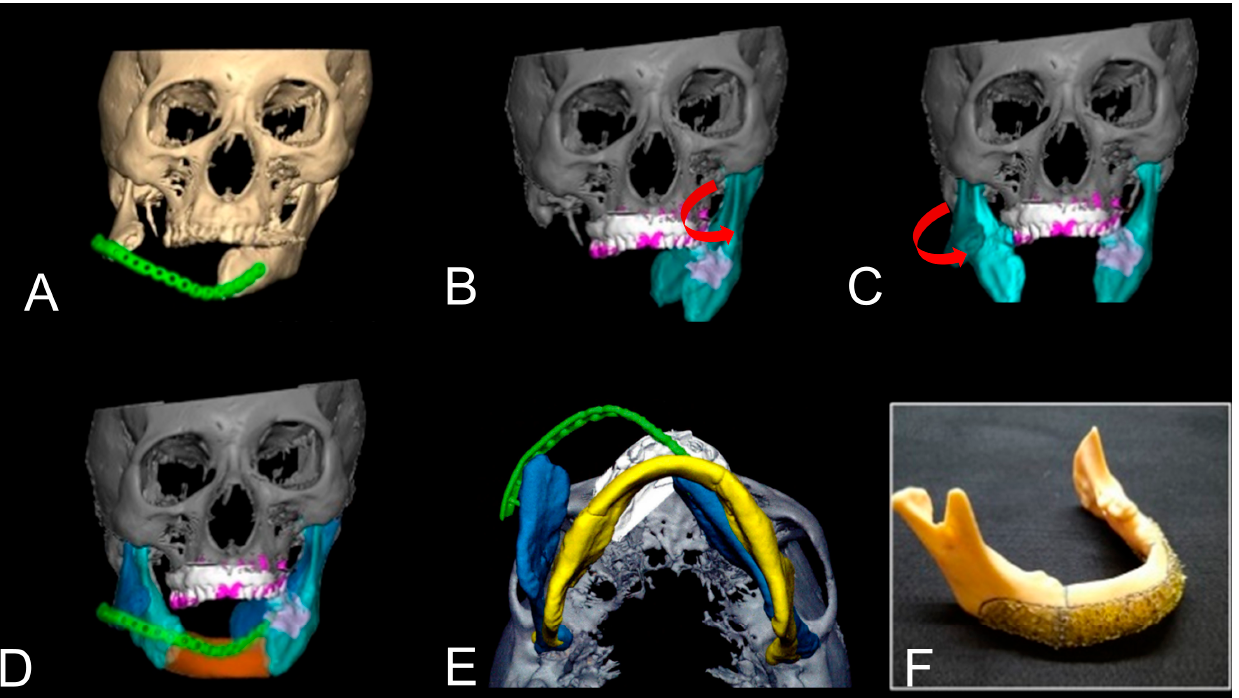
Figure 7. Complicated mandibular deviation without preoperative CT data. This was a case of bilateral segmental mandibular defect due to a tumour resection with radical neck dissection (Case 14). The defects were reconstructed with a surgical plate simultaneously. However, the surgical plate was located in the incorrect place and bilateral condylar displacements were seen. The facial appearance was poor and the alveolar bone for the dental rehabilitation was also improper ( A ). This condition made the remaining mandible deviate. The displaced condyles were adjusted digitally. Additionally, a dental arch of the maxilla was superimposed ( B , C ). The red arrow indicates the direction in which the detached mandible should be returned to its normal position ( B , C ). Since the information of the preoperative CT data could not be used due to the CT artefact, the virtual neo-mandible was therefore used for the superimposition ( D , E ). The dark brown mandible indicates a virtually grafted PCBM. The white maxilla represents the plaster model information. After these processes, the neo-mandibular morphology was reconstructed virtually. The blue mandible is the original CT data with a green surgical plate and the yellow mandible is the virtually reconstructed mandible. The positioning of the upper and lower jaws has been greatly improved ( E ). Then, a 3D model and a titanium mesh were made ( F